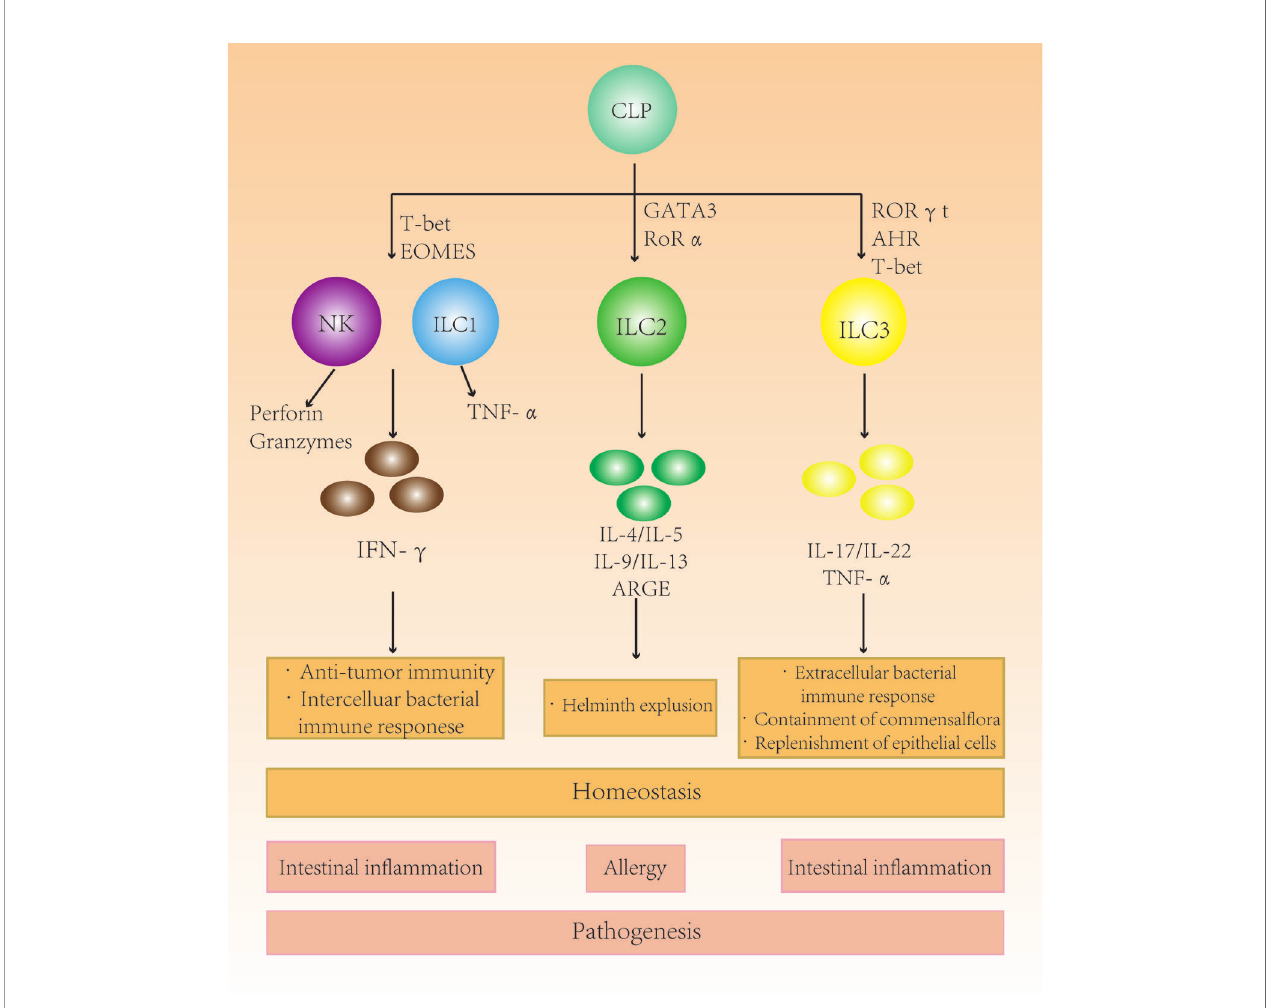
FIGURE 1 | The role of different subgroups of innate lymphoid cells (ILCs) in the intestine. Different ILC subgroups secrete different characteristic cytokines that participate in intestinal immunity and maintain homeostasis. Changes in the ILC subtype ratio and subsequent secretion imbalances in the intestine can cause intestinal